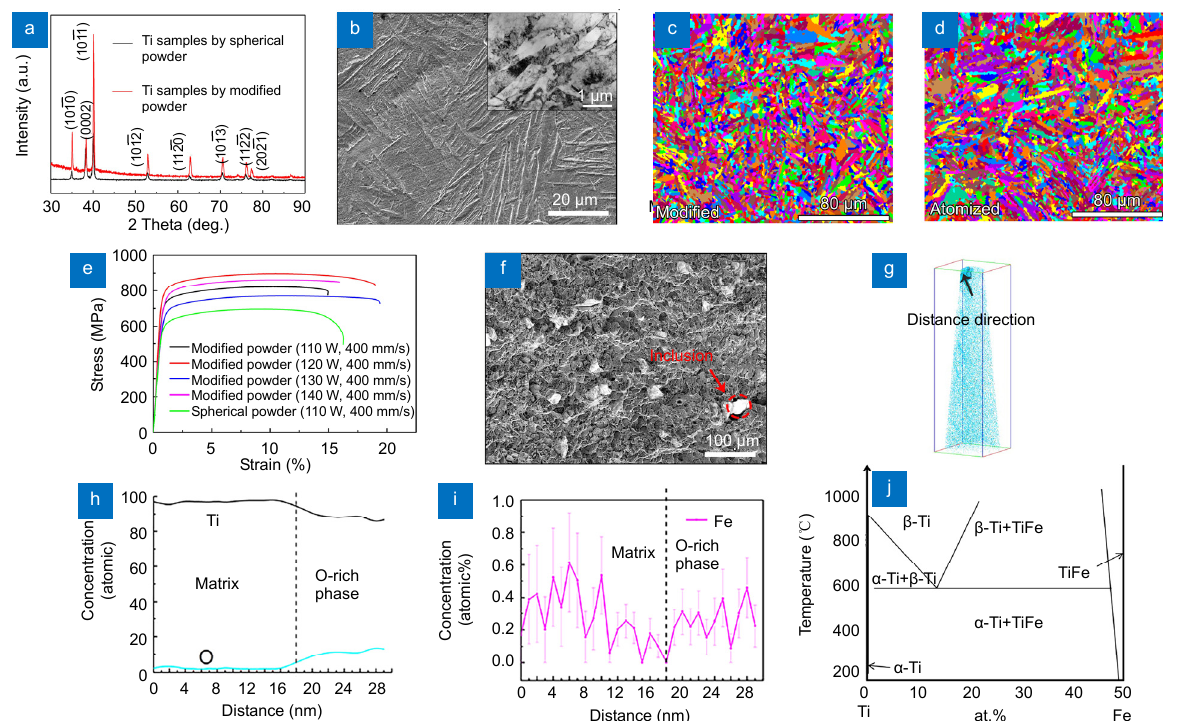
Fig. 4 | ( a ) XRD patterns for the as-printed Ti using modified powder and spherical powder. ( b ) SEM-SE image of the as-printed Ti using the modified powder; figure inset is a TEM-BF image. ( c ) EBSD result for the modified CP-Ti powder. ( d ) EBSD result for the as-purchased CP-Ti powder. ( e ) Tensile test of the as-printed Ti using the modified powder, with a comparative curve based on the commercial spherical Ti powder. ( f ) Fractography of the as-printed Ti using the modified powder, where inclusion can be occasionally found as the one marked out. ( g ) 3D APT results showing the oxygen distribution across the tip sample. ( h ) and ( i ) The corresponding concentration profiles of oxygen and Fe, and ( j ) schematic graph of part of a Ti-Fe binary phase